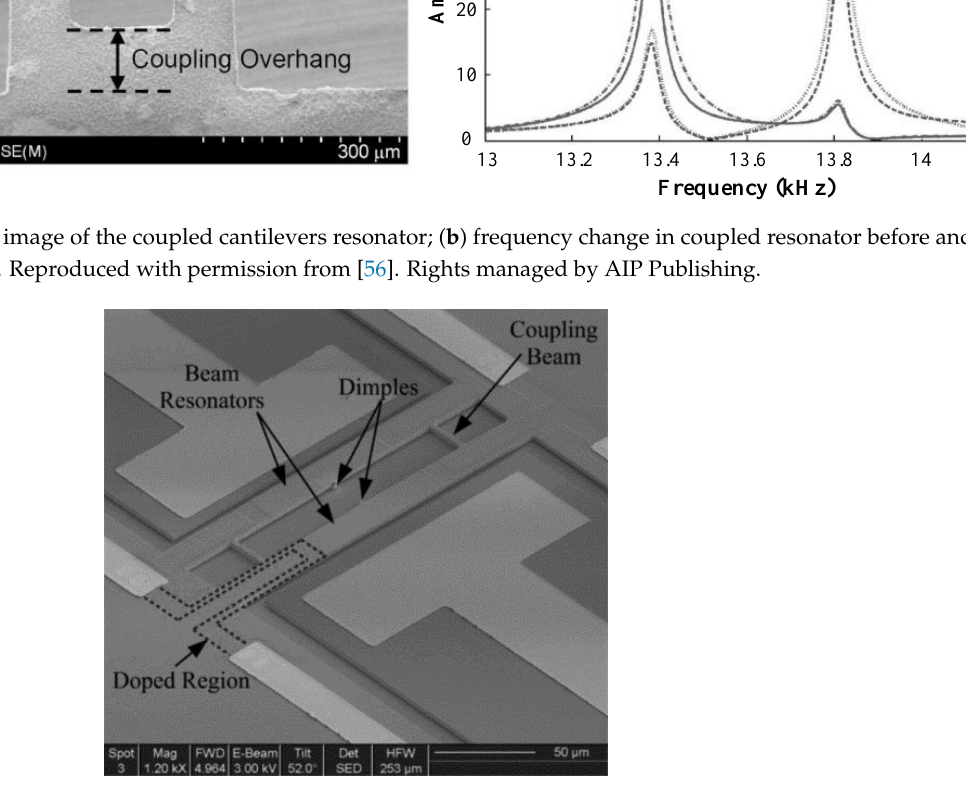
Figure 9. SEM image of the coupled cantilevers resonator. Reproduced with permission from [58]. Copyright © 2016, IEEE.